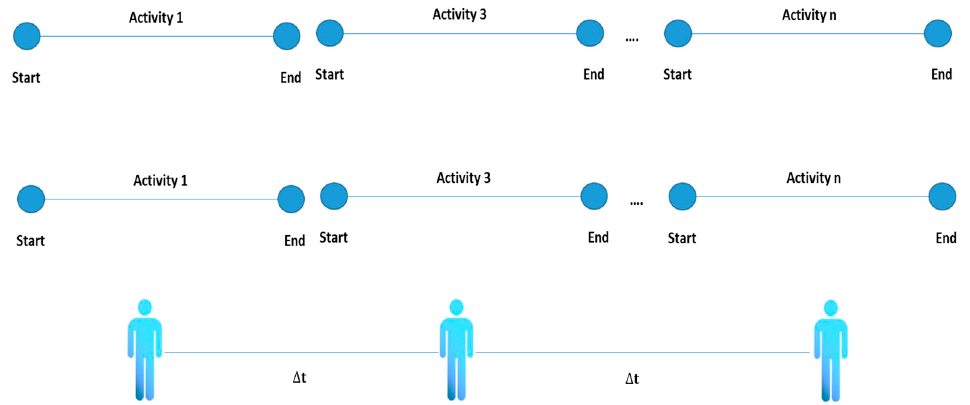
Figure 4. Multioccupancy activity representation.